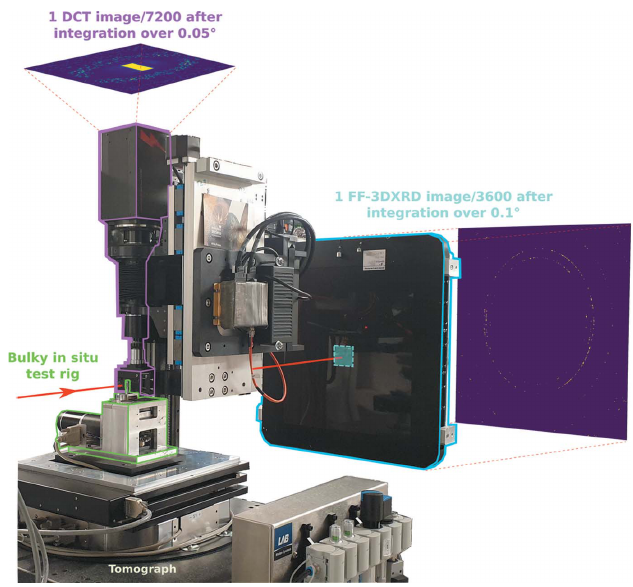
Figure 1 Overview of the multimodal experimental setup on the Psiche´ beamline at Soleil.